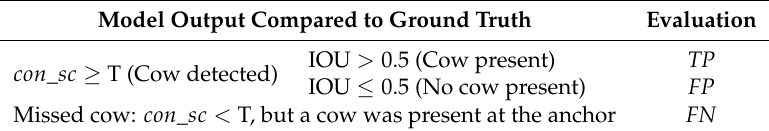
Table 2. Definition of true positives ( TP ), false positives ( FP ) and false negatives ( FN ) in object detection. TP , FP and FN were calculated for varying thresholds ‘T’ of the confidence score con_sc , a measure of whether the model detected a cow. IOU denotes the ‘Intersection over union’, a measure of whether a cow was actually